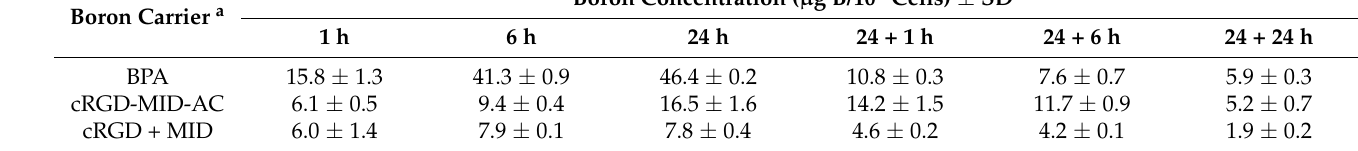
Table A3. Cellular uptake of boron in 9L rat gliosarcoma cells incubated with 10 µ g B/mL of each boron